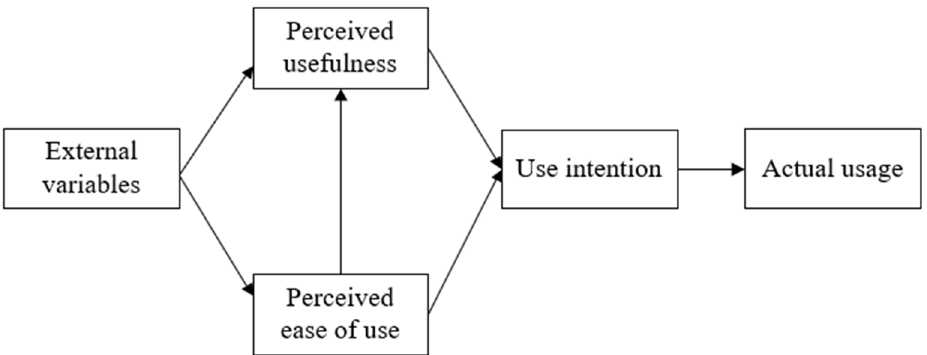
Figure 2. Technology acceptance model.